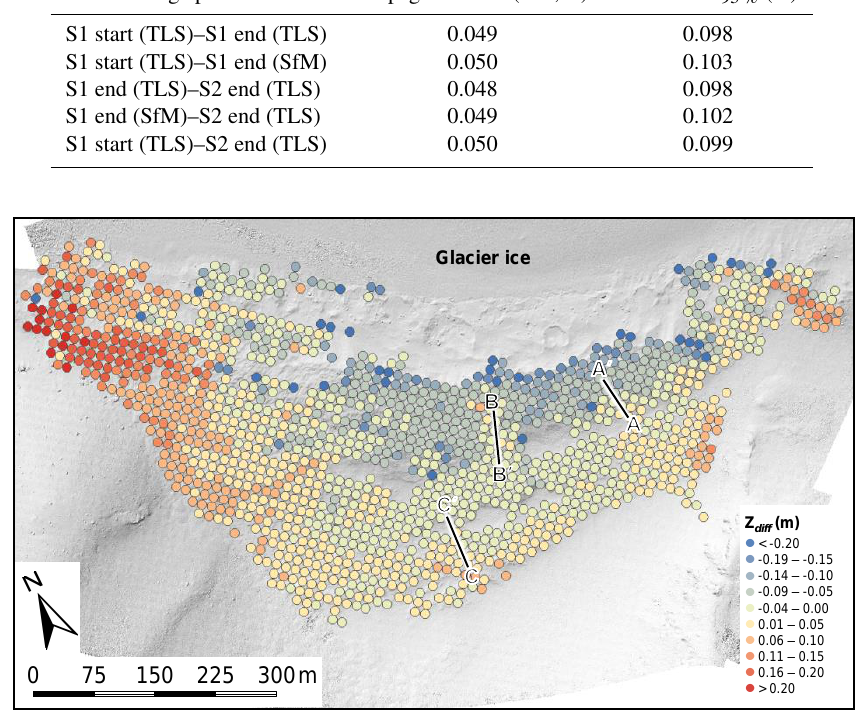
Figure 3. Results of vertical ( Z diff ;m) differencing of the UAV-SfM and TLS datasets acquired at the end of season 1, represented as the mean difference within 10m 2 grid cells. Overall, 83% of the UAV-SfM data were found to be within ± 0.1m of the equivalent TLS data. Profiles A–C are displayed in Fig.